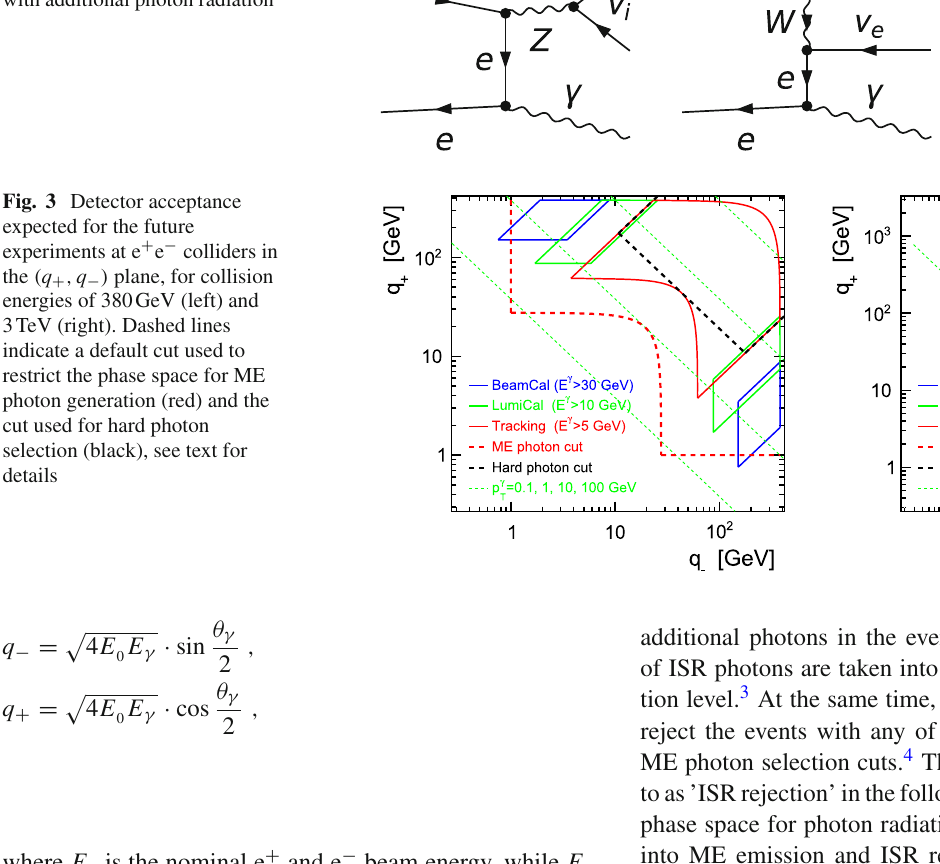
Fig. 2 Diagrams describing the neutrino pair production process with additional photon radiation